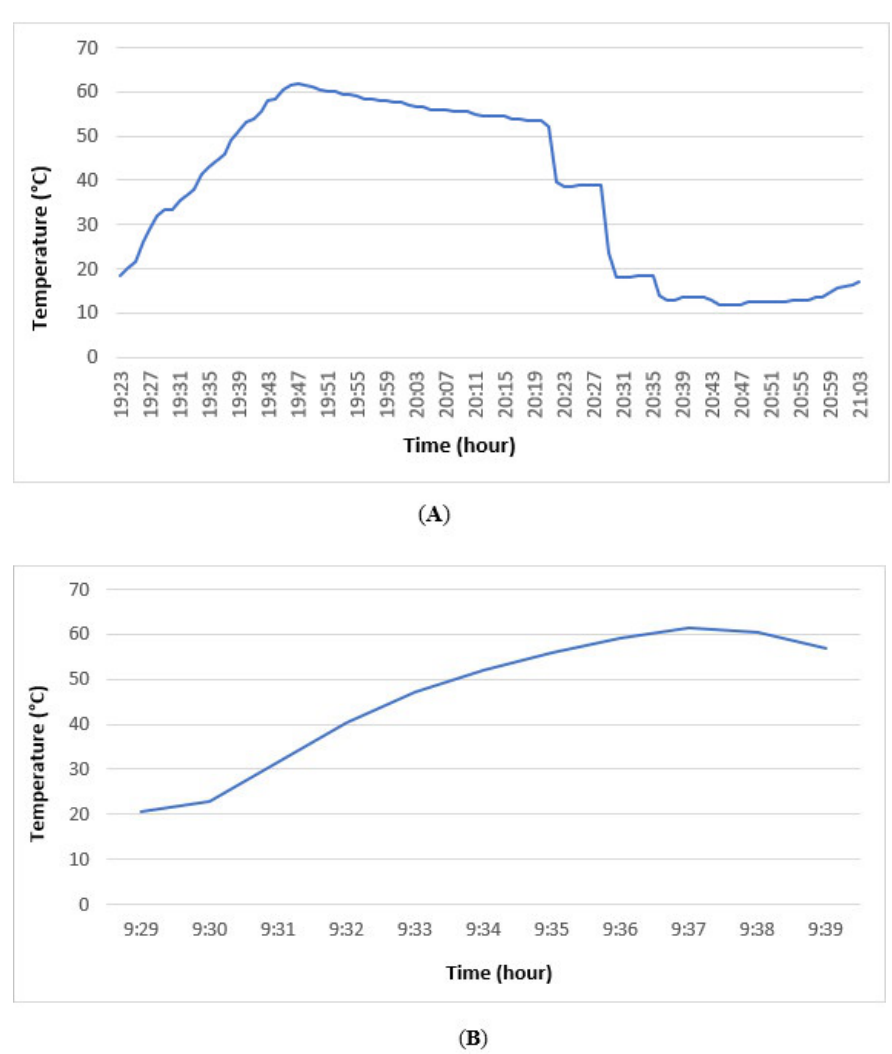
Figure 1. ( A ) Temperature courses of the laundering program at 60 ◦ C for 100 min using domestic machine; ( B ) temperature variations during heat drying performed using